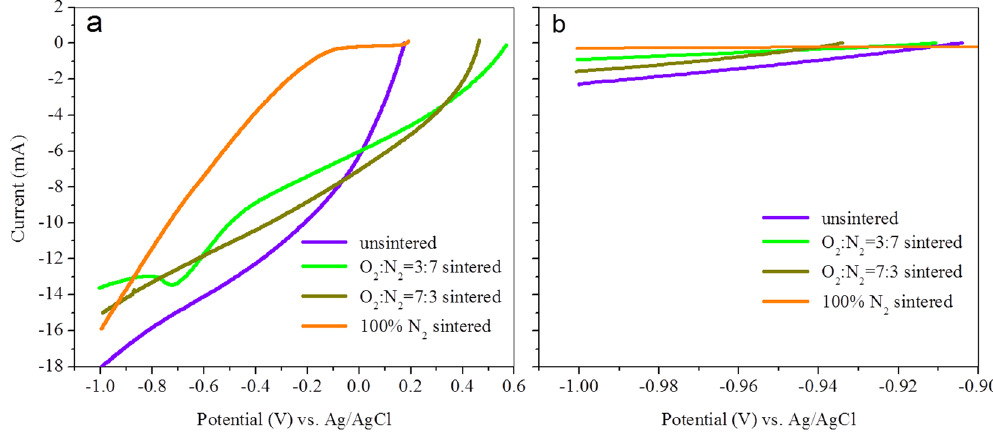
Figure 1. Linear sweep voltammetry (LSV) curves of CB electrodes ( a : the curves of newly fabricated electrodes with different pre-treatments, b : corresponding curves of charged (fully saturated with electrons)